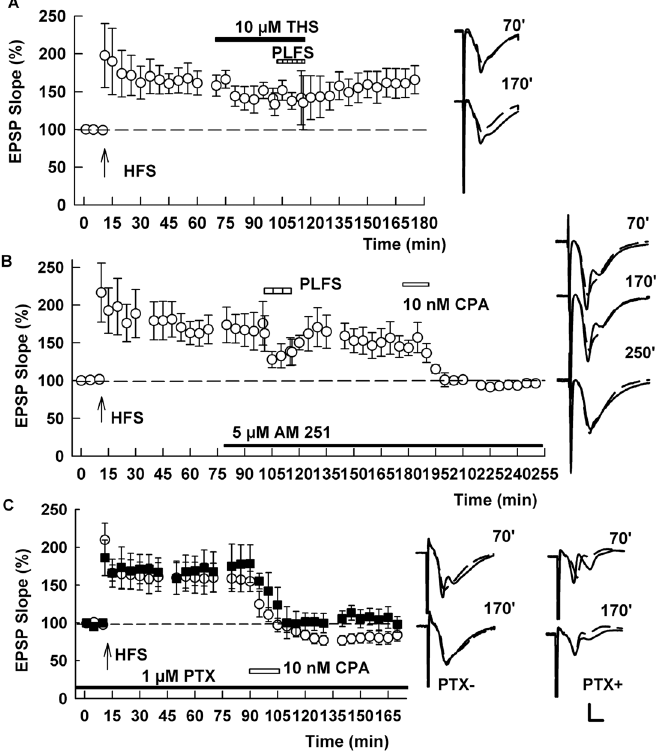
Fig 5. Endocannabinoids contribute to TA-induced LTP-D of SC synapses. (A) Treatment of slices with 10 μ M tetrahydrolipstatin (THS, black bar), an inhibitor of diacylglycerol lipase and 2AG synthesis, blocked the ability of PLFS (hatched bar) to depotentiate SC LTP. SC HFS was administered at the arrow. (B) TA- induced LTP-D was also blocked by 5 μ M AM251, a CB1 receptor antagonist (black bar). AM251, however, did not block the ability of 10 nM cyclopentyladenosine (CPA, white bar), an adenosine A1 receptor agonist, to induce chemical depotentiation of SC LTP. (C) PTX (black bar) also failed to alter depotentiation by CPA (white bar) as shown with black squares. White circles show effects of CPA in the absence of PTX. Traces show representative EPSPs. Calibration: 1 mV, 5 ms.